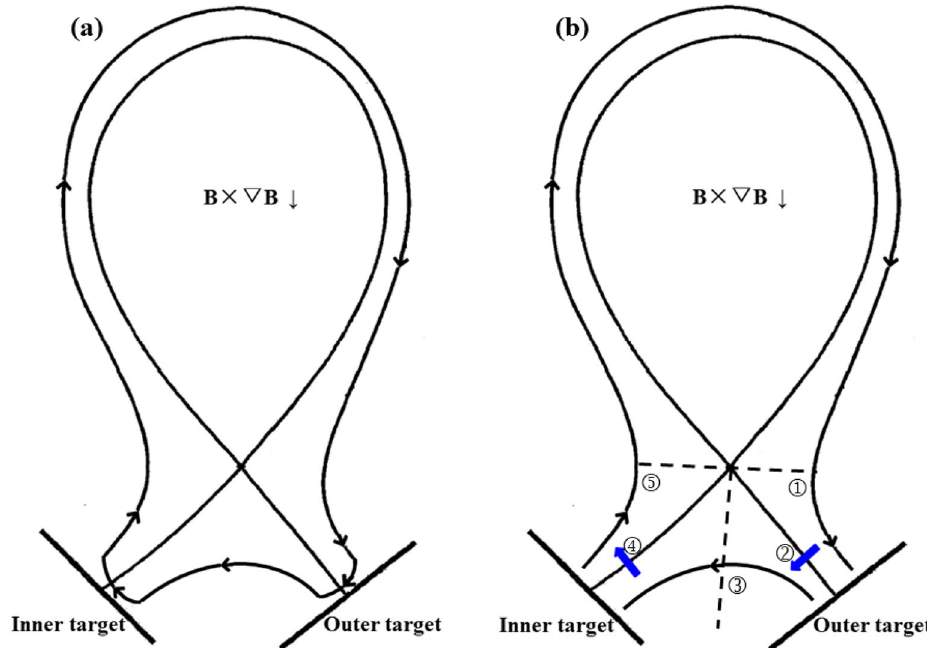
Figure 5. The diagrams of the directions of diamagnetic drift flow (left) and E × B drift flow (right) in the SOL and PFR regions for tokamak plasmas with normal toroidal magnetic field. In the right figure, the black arrows represent the direction of poloidal E × B drift flow while the blue arrows represent the direction of radial E × B drift flow. ➀ : interface of the low field side upstream and the outer divertor region; ➁ : interface of the SOL and PFR at the outer divertor region; ➂ : interface of the outer and inner PFR region; ➃ : interface of the SOL and PFR at the inner divertor region; ➄ : interface of the high field side upstream and the inner divertor region.